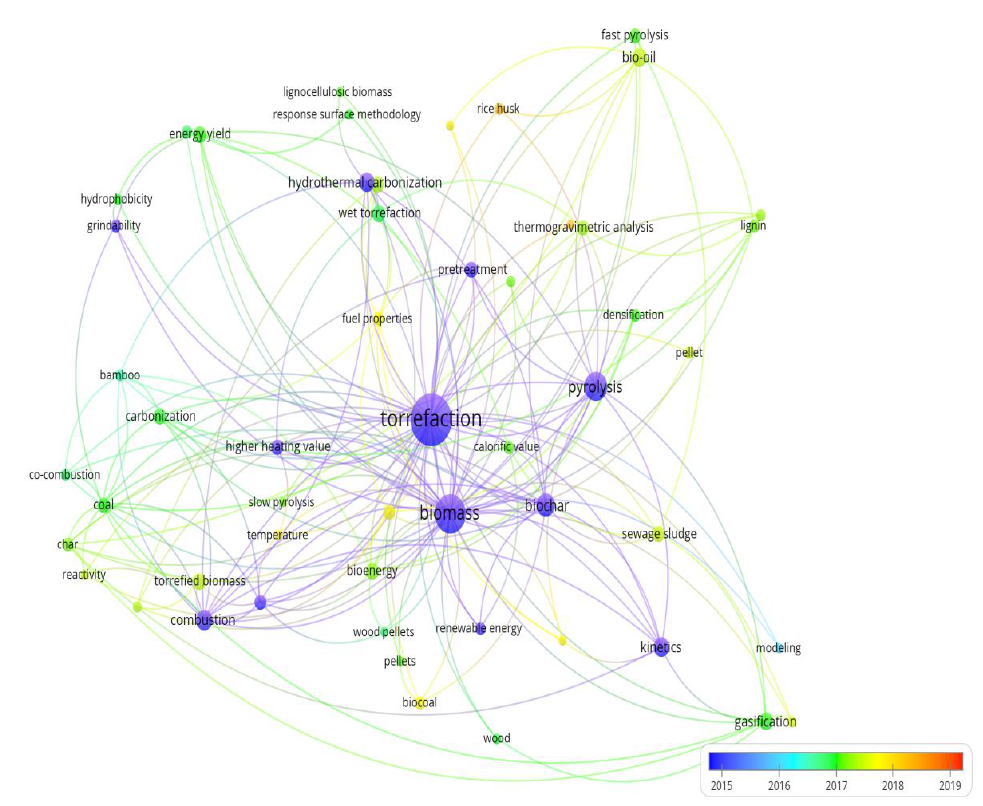
Figure 8. Map of term words for individual years — 2015 – 2019.